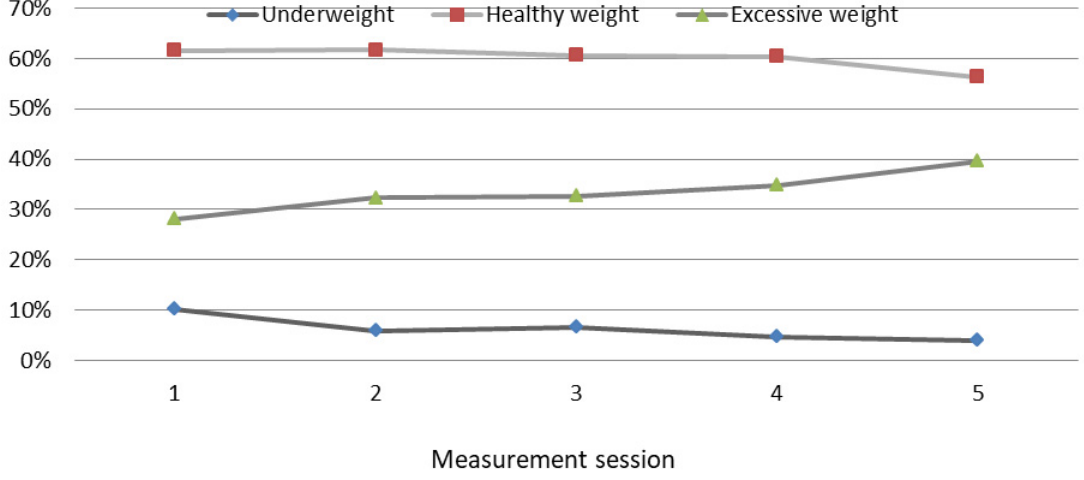
Figure 2. Changes in the body fat content category in GC children during the course of the study. Excessive weight—overweight and obesity. Changes in the fat mass % category in GC children during the course of the study.